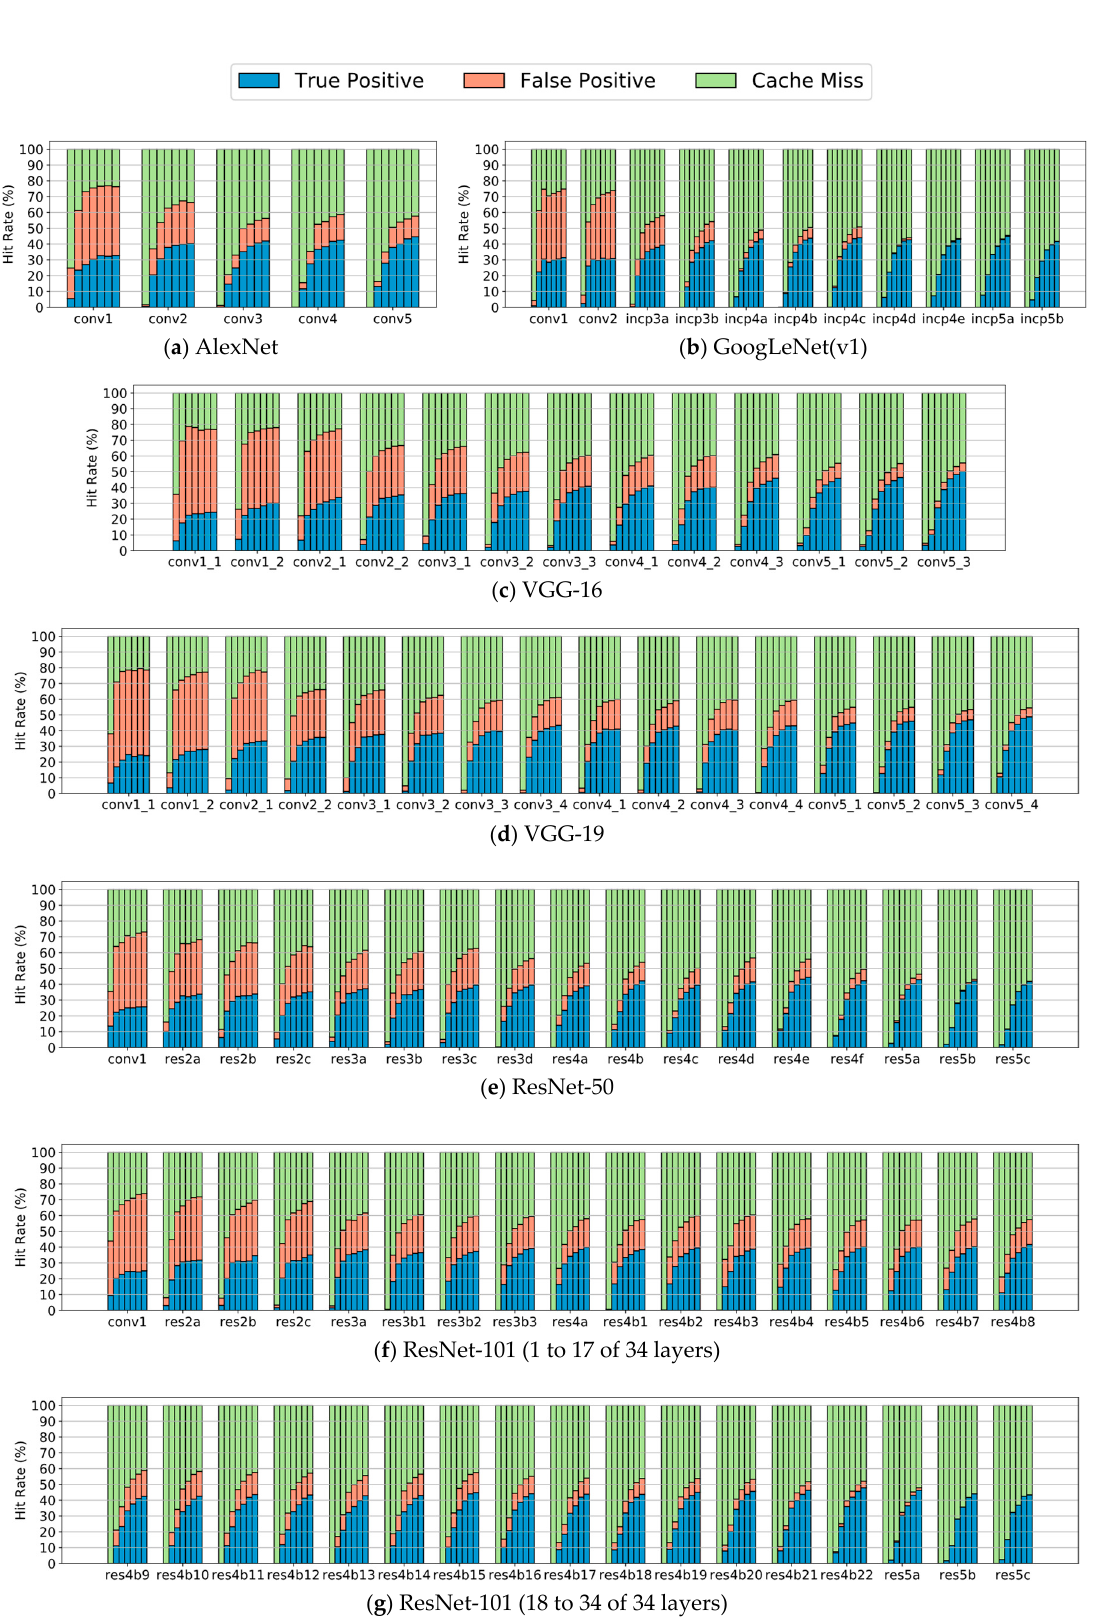
Figure 6. Hit rate of cache when applying the distance threshold. In this case, most false positives can be treated as Cache Misses to improve cache efficiency. 222